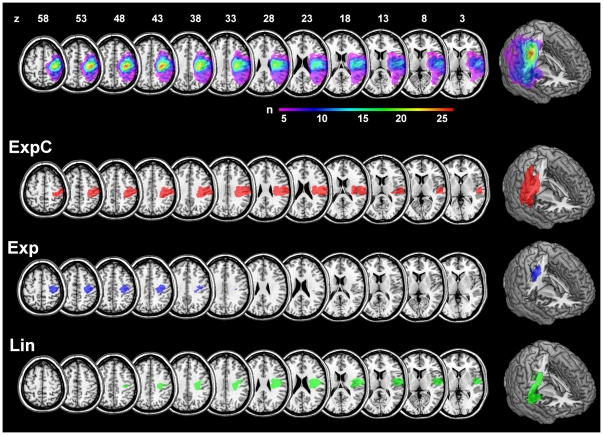
Anatomical overview.Lesion overlap maps for all patients (upper-most row). Rows below show the core maps of subgroups ExpC, Exp and Lin overlaid onto on a standard single-subject brain template. Maps represent voxels were at least 90% of patients overlap (threshold for ExpC and Lin: n = 5; for Exp: n = 15). Images are in neurological convention (left side of the image is left side of the brain) and z-coordinates are given in MNI stereotaxic space. Right-most column shows three-dimensional renderings with a vertical cut through the maximum overlap of the complete cohort.